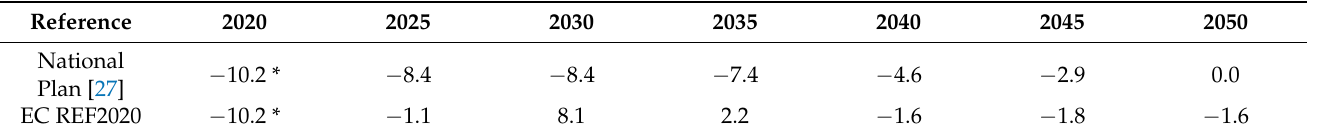
Table 3. Net electricity imports